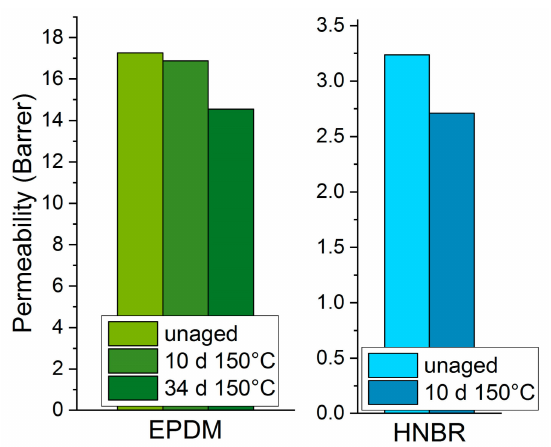
Figure 5. Oxygen permeability of EPDM and HNBR. Note the di ff erent scales for each